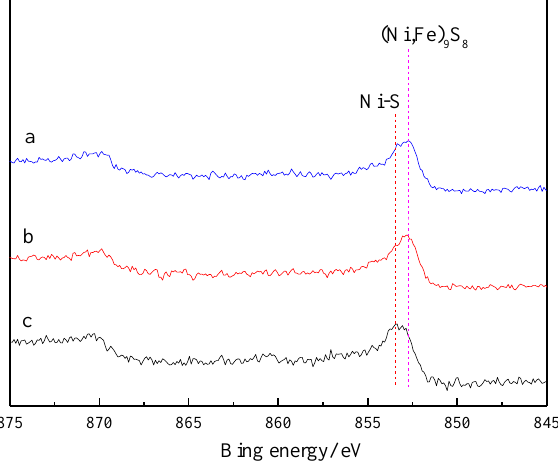
Figure 8. Ni 2p XPS spectra of leached pentlandite with di ff erent conditions: ( a ) initial Fe 3 + = 0 g / L, leached for 14 days; ( b ) initial Fe 3 + = 3 g / L, leached for 14 days; (c) initial Fe 3 + = 9 g / L, leached for 52 days .